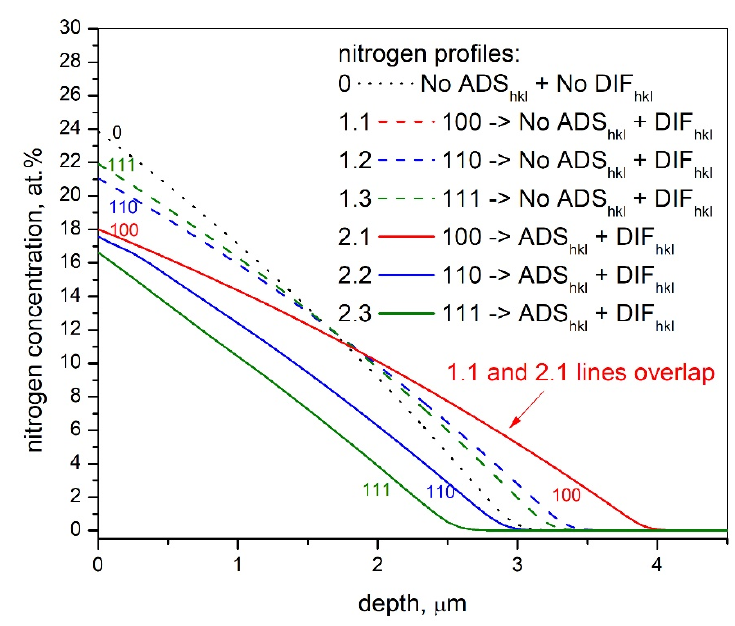
Figure 2. Depth profiles of nitrogen for di ff erent orientations of crystallites, calculated for three di ff erent cases: (0) isotropic surface processes and isotropic di ff usion (No ADS hkl + No DIF hkl ), (1) isotropic surface processes and anisotropic di ff usion (No ADS hkl + DIF hkl ), and (2) anisotropic surface processes and anisotropic di ff usion (ADS hkl + DIF hkl ).